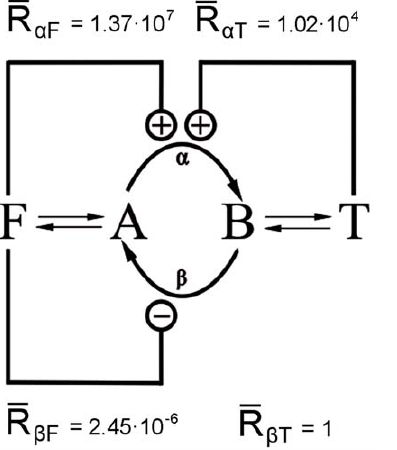
Figure 6. Resulting regulation scheme drawn from the consensus set of parameters. Enzyme a is activated by both effectors F and T ( R a , F w 1 and R a , T w 1 ) whereas enzyme b i s inhibited ( R b , F v 1 ) by F and T has no effect on it ( R b , T ~ 1 ). The corresponding optimized parameters are: K a ,F =1.5 ? 10 2 2 , K a ,T =5.5 ? 10 3 , K b ,F =9.2 ? 10 2 8 , K b ,T = 3.7 ? 10 7 , r a ,F = 1.9 ? 10 7 , r a ,T =2.3 ? 10 9 , r b ,F = 1.6 ? 10 2 7 , r b ,T =3.65.